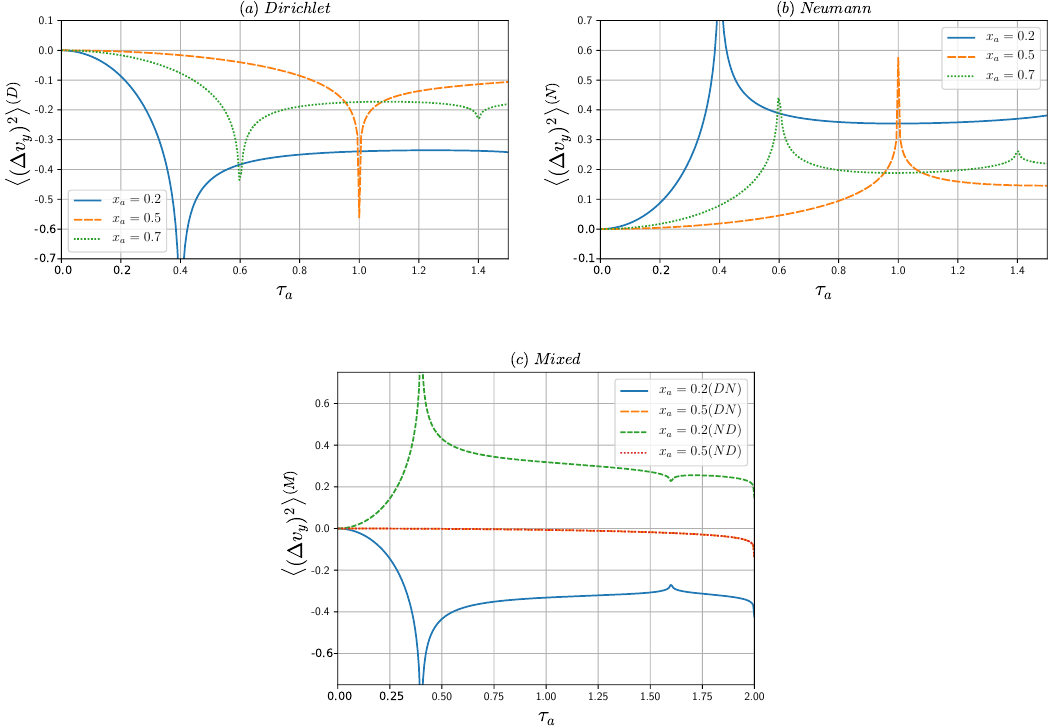
Figure 4 . Graph behavior of the parallel velocity dispersion curves for (a) Dirichlet (D), (b) Neumann (N) and (c) mixed (DN, ND) boundary conditions. Here we have considered the curves (cid:16) (cid:17) 2 ma in units of h (∆ v y ) 2 i (i) = h (∆ v y ) 2 i (i) ren . Note that the shown peaks represent divergent g